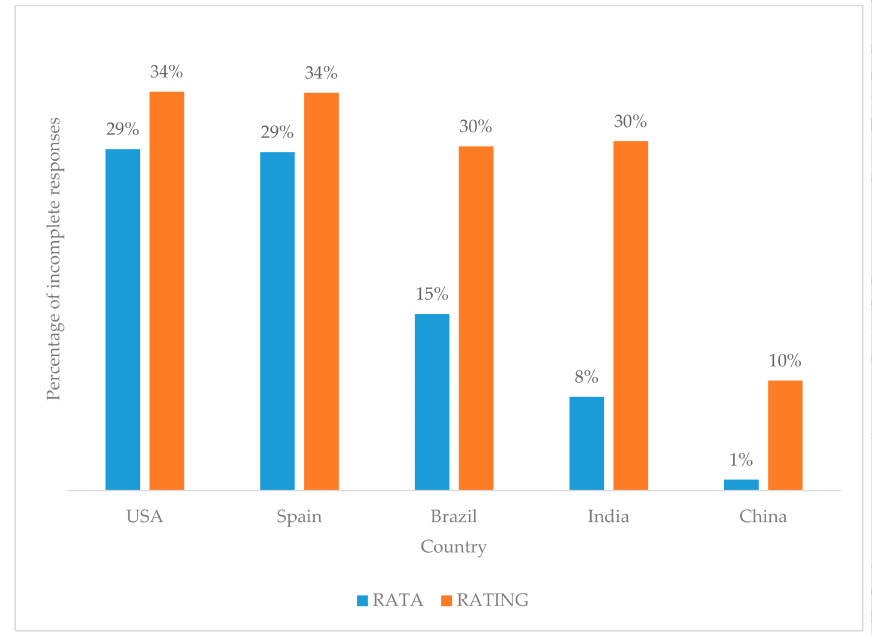
Figure 2. Percentage of incomplete responses for RATA and RATING per country. Incomplete ques- tionnaires were not accepted or used and were not counted in the approximately 200 responses received per country per questionnaire type. Table 6. Means and standard deviations † and p -values for the survey mean duration for RATA and RATING per country. Brazil